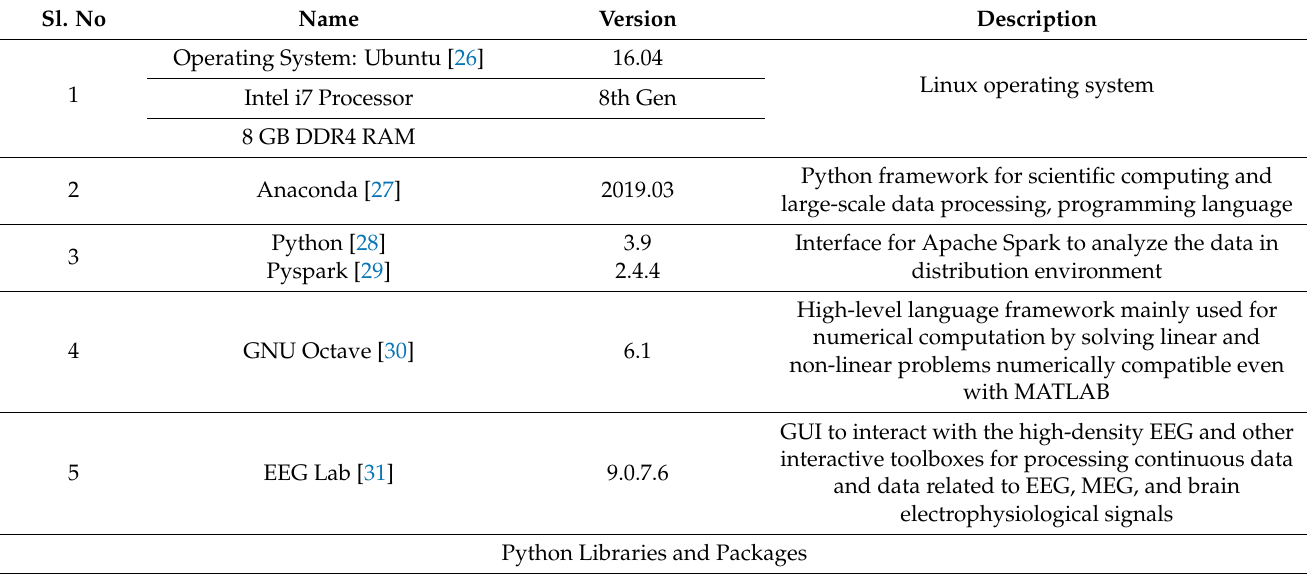
Table 3. Hardware and software